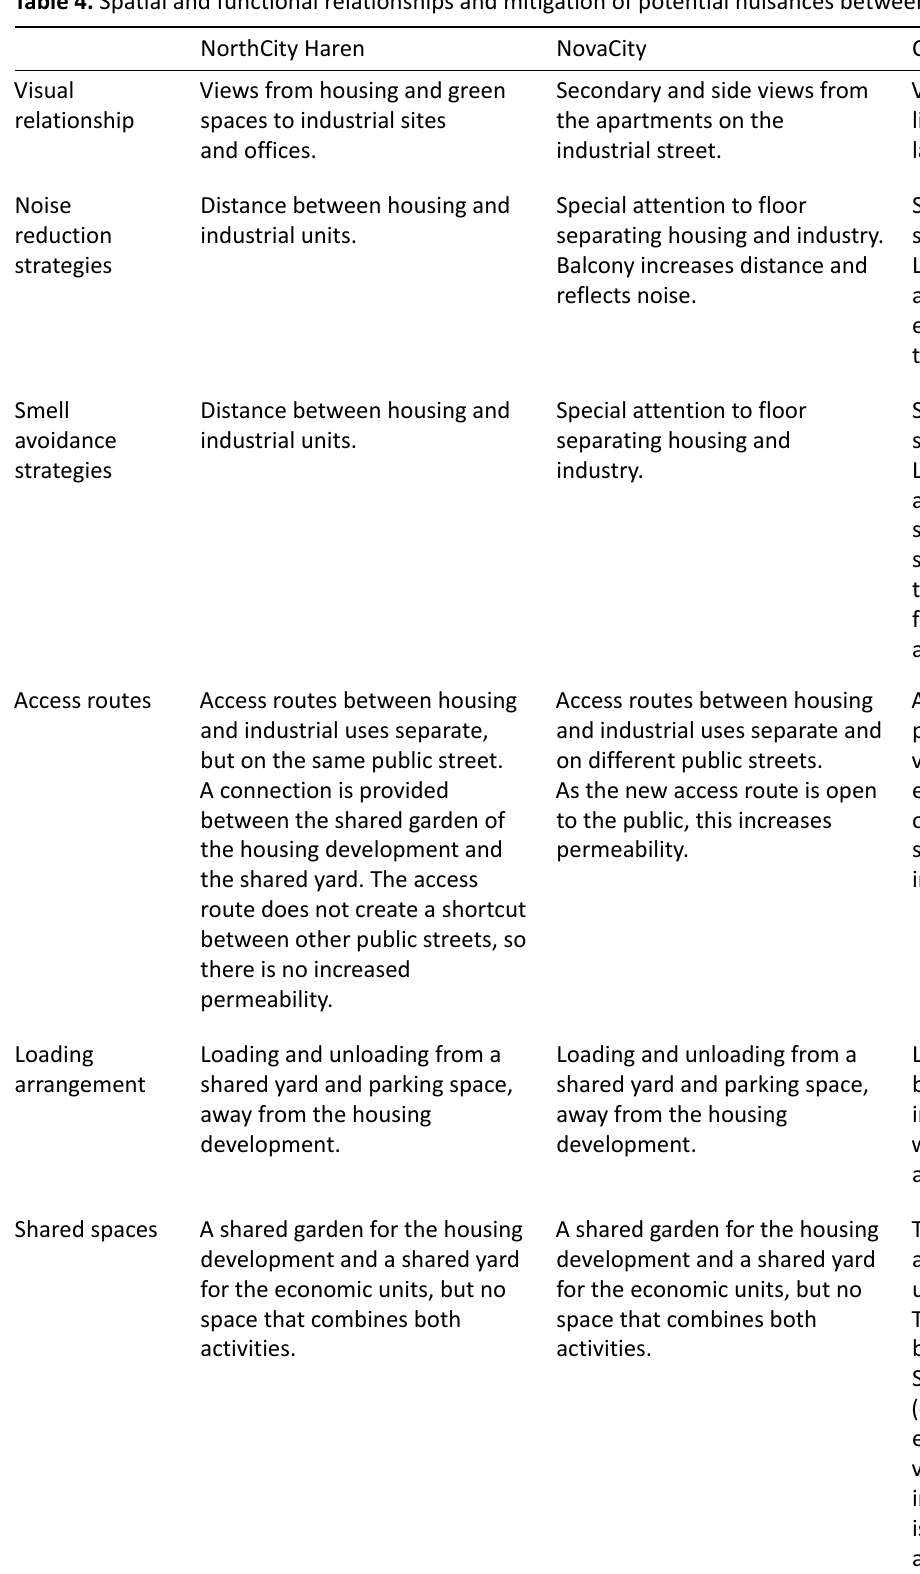
Table 4. Spatial and functional relationships and mitigation of potential nuisances between land